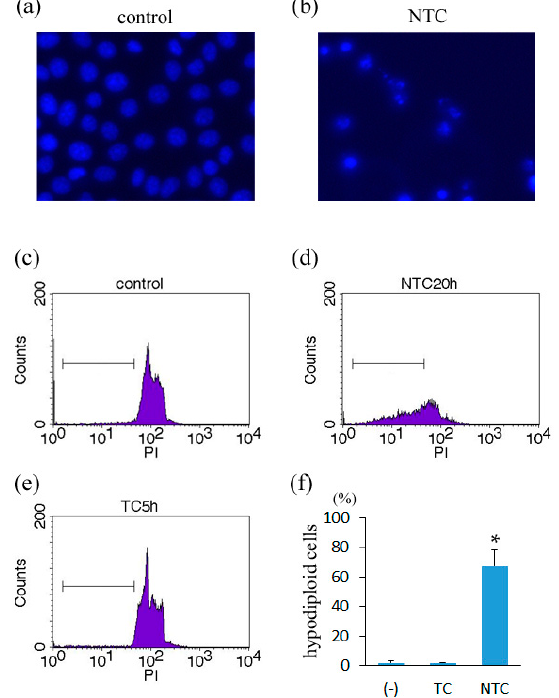
Figure 4. Induction of apoptosis in Nec/TNF/CHX-treated L929 cells (nuclear fragmentation). ( a , b ) Hoechst 33342 staining (original magnification 200×). L929 cells were treated with 10 μ M necrostatin-1 (N), 10 ng/mL TNF (T), and 10 μ g/mL cycloheximide (C) for 20 h; ( c – f ) Cellular DNA content was analyzed using flow cytometry. L929 cells were treated with ( d ) 10 μ M necrostatin-1 (N), 10 ng/mL TNF (T), and 10 μ g/mL cycloheximide (C) for 20 h, or ( e ) 10 ng/mL TNF (T) and 10 μ g/mL cycloheximide (C) for 5 h. The graph shows the average of three independent experiments. The bars indicate one standard deviation. * p < 0.01 compared with non-treated control. PI, propidium iodide.